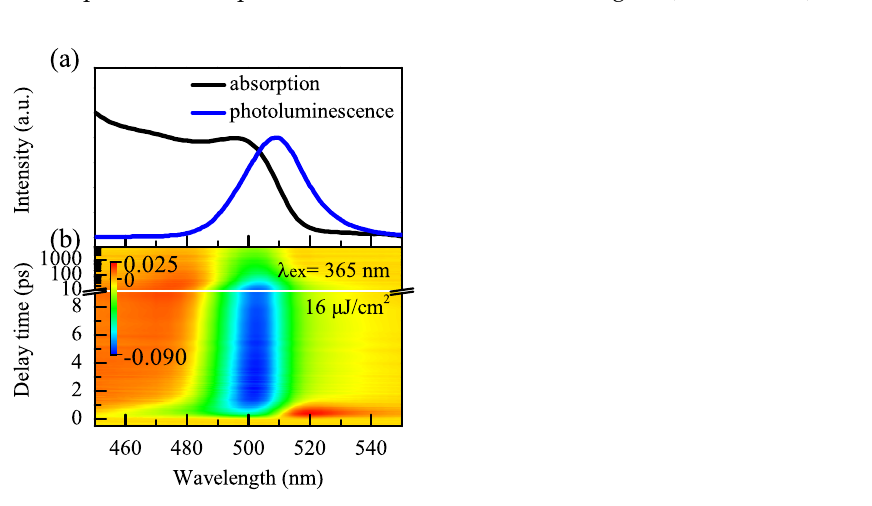
Figure 2. ( a ) SS absorption (black solid line) and PL spectra (blue dashed line) of CsPbBr 3 NCs. ( b ) TA contour with an excitation energy of 16 µ J/cm 2